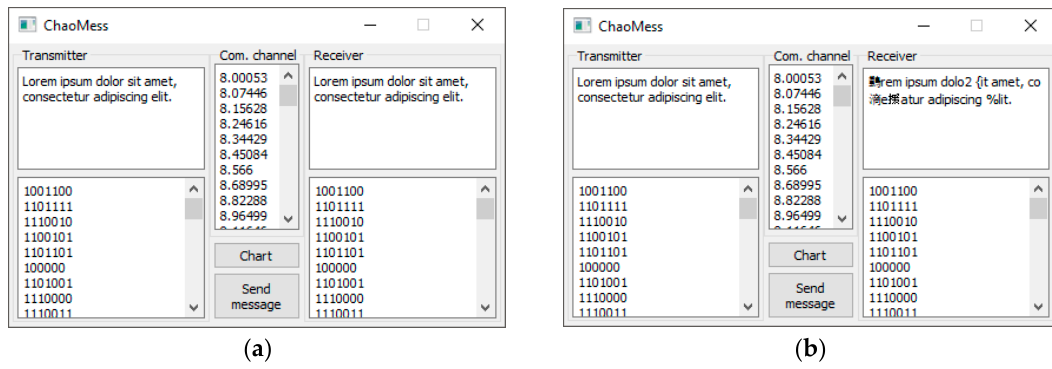
Figure 20. Testbed main window after message delivery. ( a ) number of iterations: 20,000; ( b ) number of iterations: 8000.